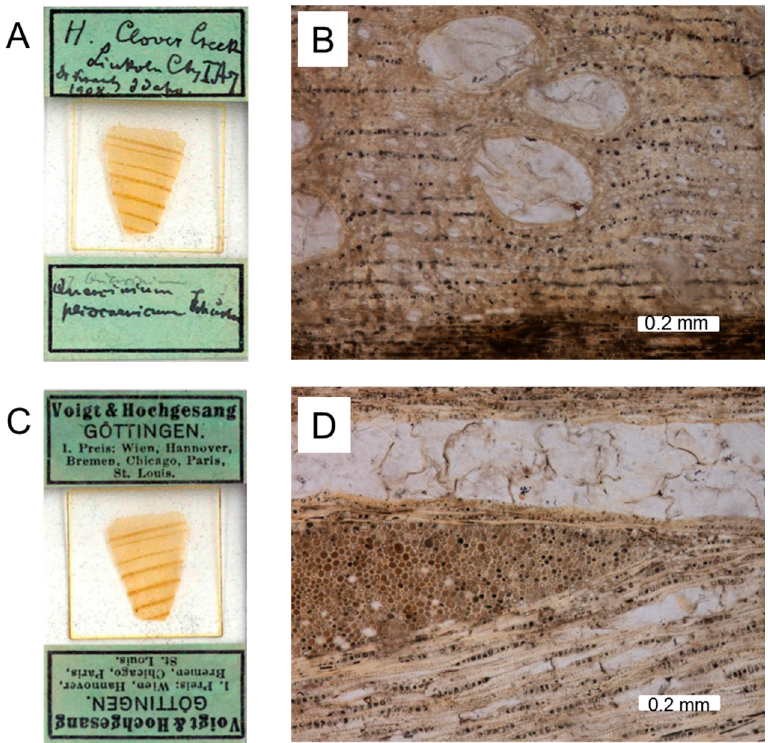
Figure 2. ( A ,) back side of an original thin section (transverse plane) examined by Schuster [7]; ( B ) recently taken OM micrograph showing transverse plane; ( C ) front side of original thin section; ( D ) recent OM micrograph showing an original thin section in the tangential longitudinal plane.